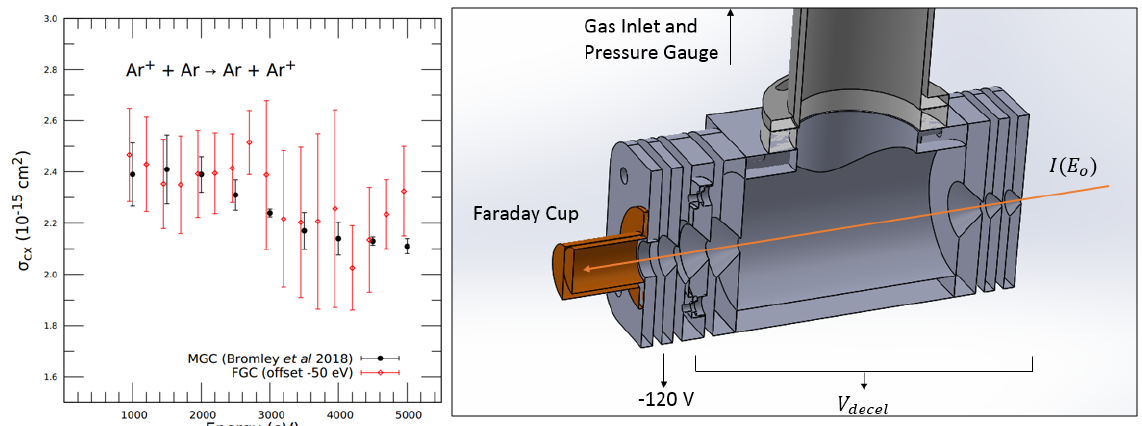
Figure 3. ( Left ) Comparison of σ cx for Ar + symmetric charge exchange measured with the floating gas cell (FGC) and the manipulator gas cell (MGC) from [22]. Data for the FGC is offset − 50 eV for clarity. ( Right ) Cut-away view of the FGC. Shown is the gas inlet, MACOR spacer (mesh not shown), and gas cell components with knife edges. The direction of the incoming beam is indicated by the orange